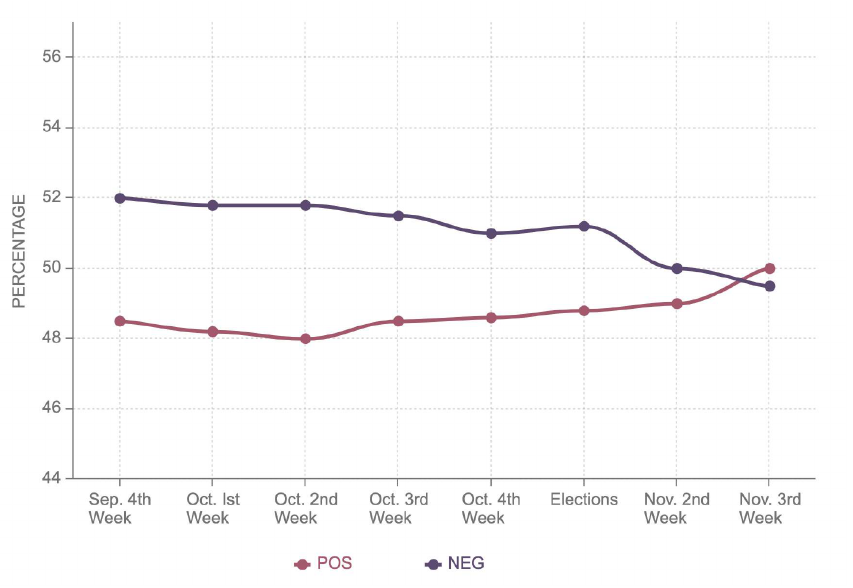
Figure 14. Graphs of positive and negative sentiments of Biden in